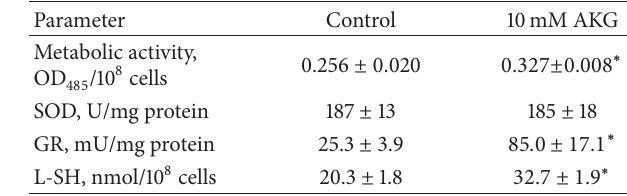
Table 2: Effect of different stressors on survival (%) of S. cerevisiae YPH250 cells grown in the absence (control) or presence of 10mM AKG.